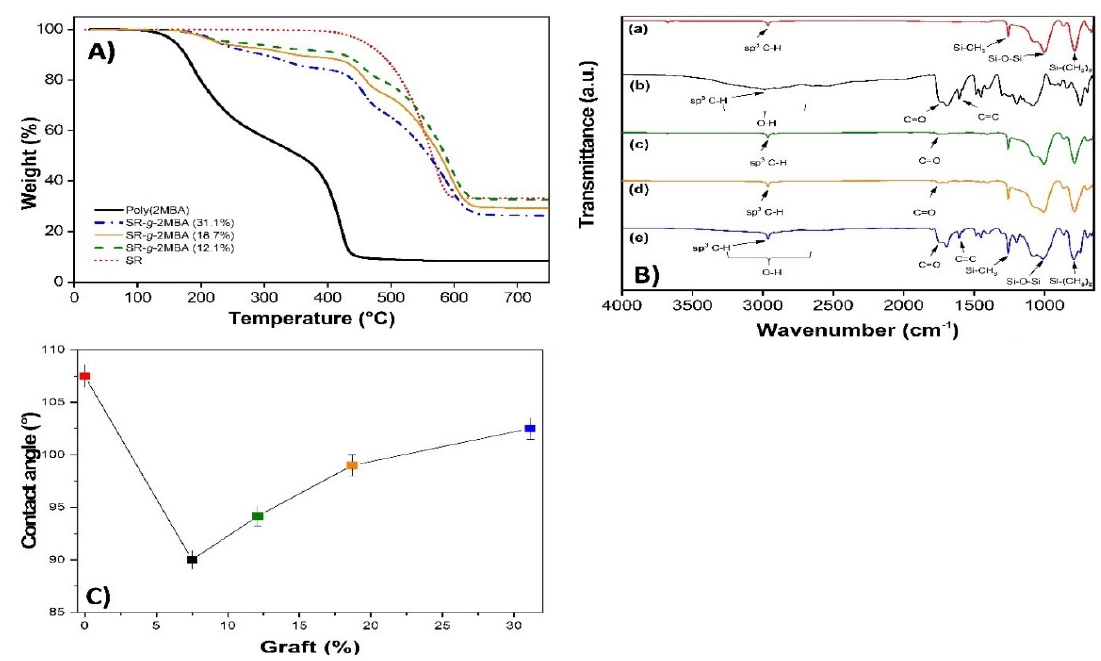
Figure 2. ( A ) Thermogravimetric analysis (TGA) scans of SR; SR- g -2MBA with 12.1%, 18.7%, and 31.1% graft; and poly(2MBA). ( B ) FTIR-ATR spectra of SR (a), poly(2MBA) (b), SR- g -2MBA 12.1% (c), SR- g -2MBA 18.1% (d), and SR-g-2MBA 31.1% (e). ( C ) Water contact of SR and SR- g -2MBA with grafting from 7.1% to